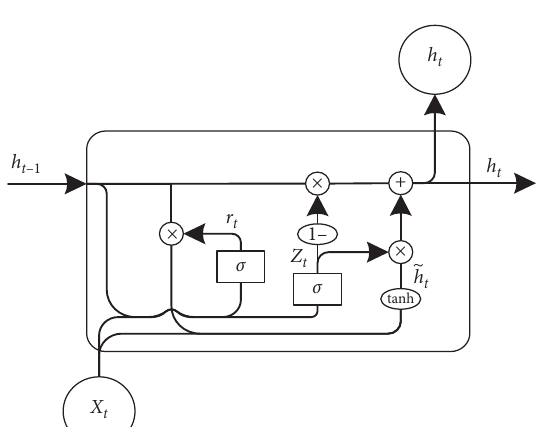
Figure 6: Internal structure of GRU.